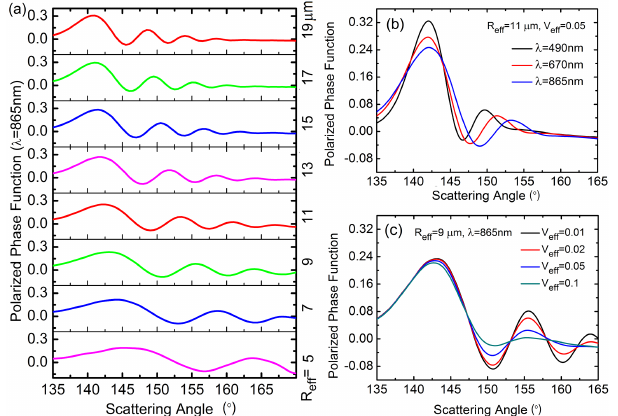
Figure 1. Simulations of polarized phase function ( P p ) for various droplet effective radii, effective variances, and wavelengths. The left plot shows how P p varies with the effective radius; the bottom right plot shows P p for various EV, while the upper right plot shows the same for three